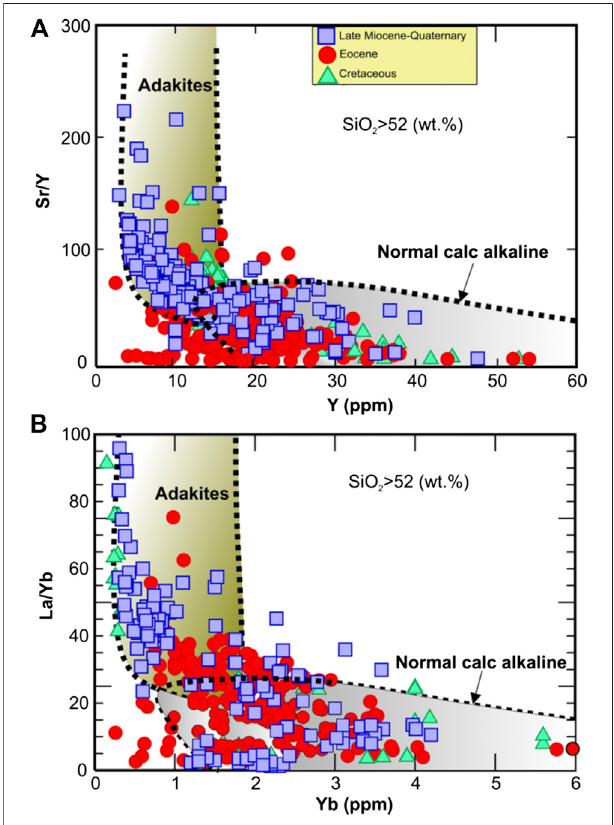
FIGURE10| Someintermediate-to-acidicrockshavehigherratiosofSr/ Y and La/Yb and are classi fi ed as adakite (A and B) . See the text for more information. For source data and references, see Supplementary S2